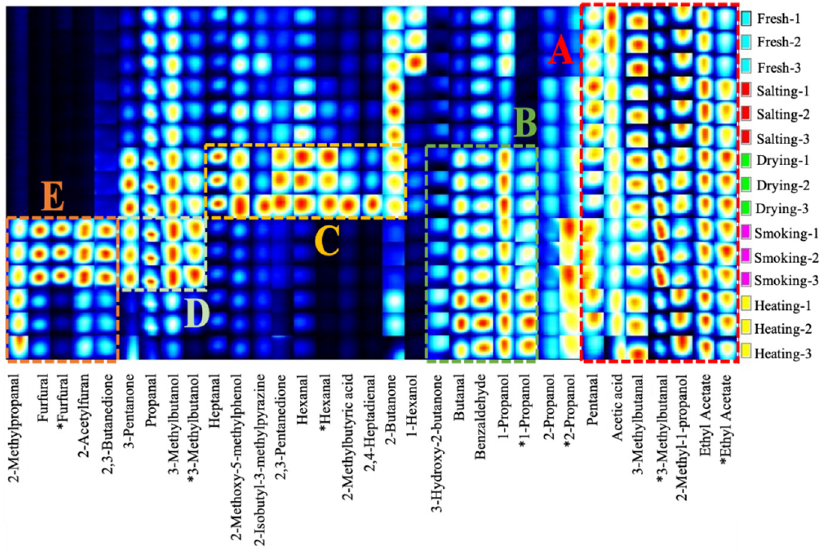
Figure 5. Gallery plot based on the signal intensity of smoke-flavored sea bass with different produc- tion steps via HS-GC-IMS. * Dimers formed in the IMS drift tube were represented by symbol “*”. PCA analysis could clearly highlight the volatile compounds differences in various processing stages based on the volatile compounds area signal intensity (Figure 6). The larger the sample distance in the figure, the more significant the difference between samples. The score chart shows that three principal components (PC1, PC2 and PC3) were obtained which accounted for 86.7% of the total variation. PC1, PC2, and PC3 explained 43.3%, 29.8%, and 13.6% of the variation, respectively. The distance between the samples in the heated and the others was significantly different, which indicated that volatile compounds in the heated sample was significantly different from other samples. Furthermore, the flavor curves of the dried and smoked samples were also different from those of other samples.